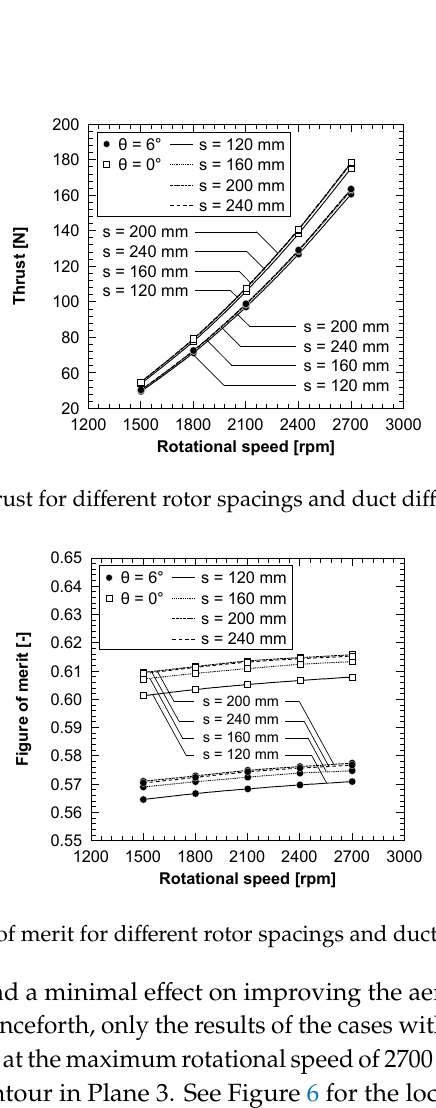
Figure 9. Total pressure contour in Plane 3 at 2700 rpm for: ( a ) 𝜃 = 6°, s = 120 mm; ( b ) 𝜃 = 6°, s = 200 mm; ( c ) 𝜃 = 0°, s = 120 mm; and ( d ) 𝜃 = 0°, s = 200 mm. See Figure 6 for the location of Plane 3.